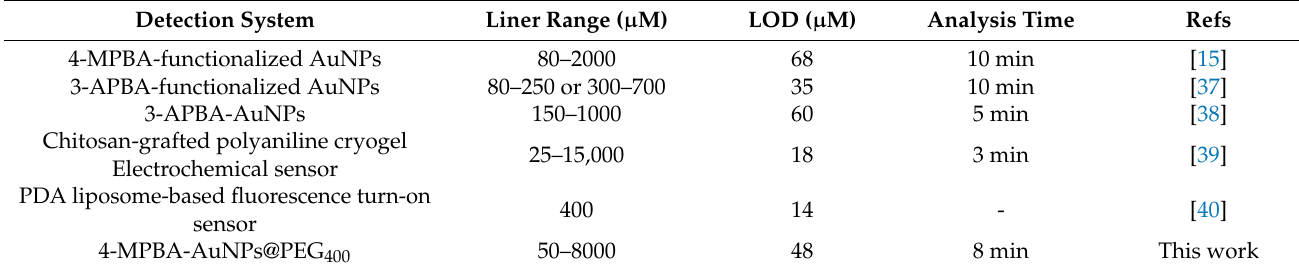
Table 1. Performance comparison of different SA-sensing techniques.